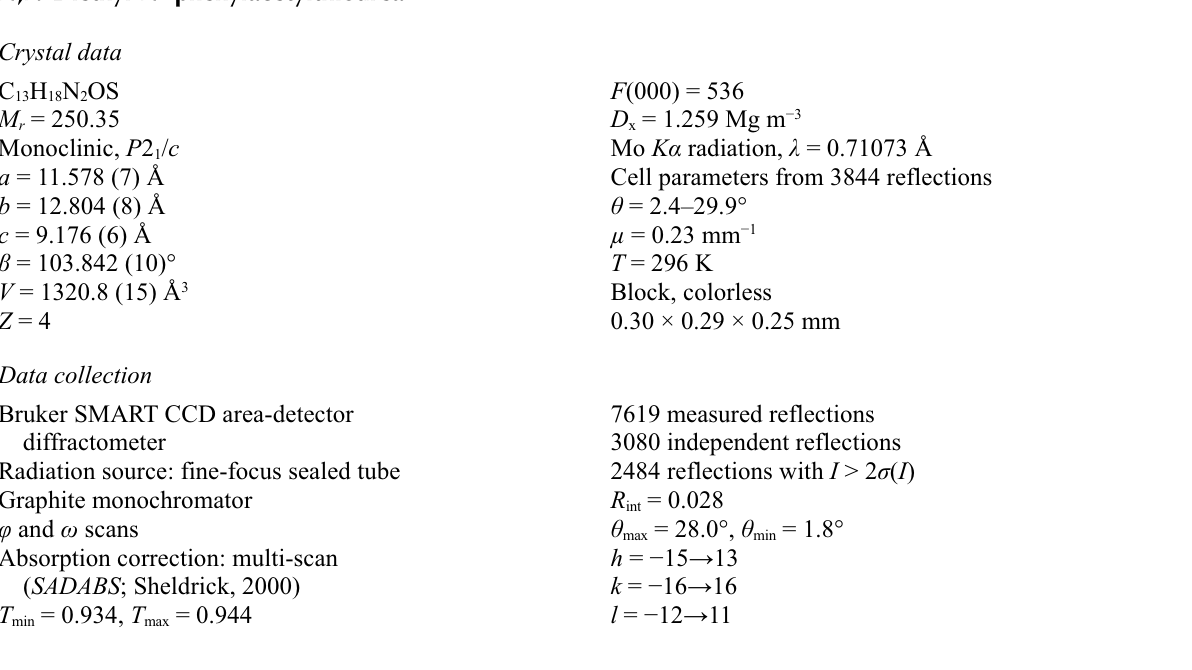
Packing diagram of the title compound viewed along the c axis. Intermolecular hydrogen bonds are shown as dashed